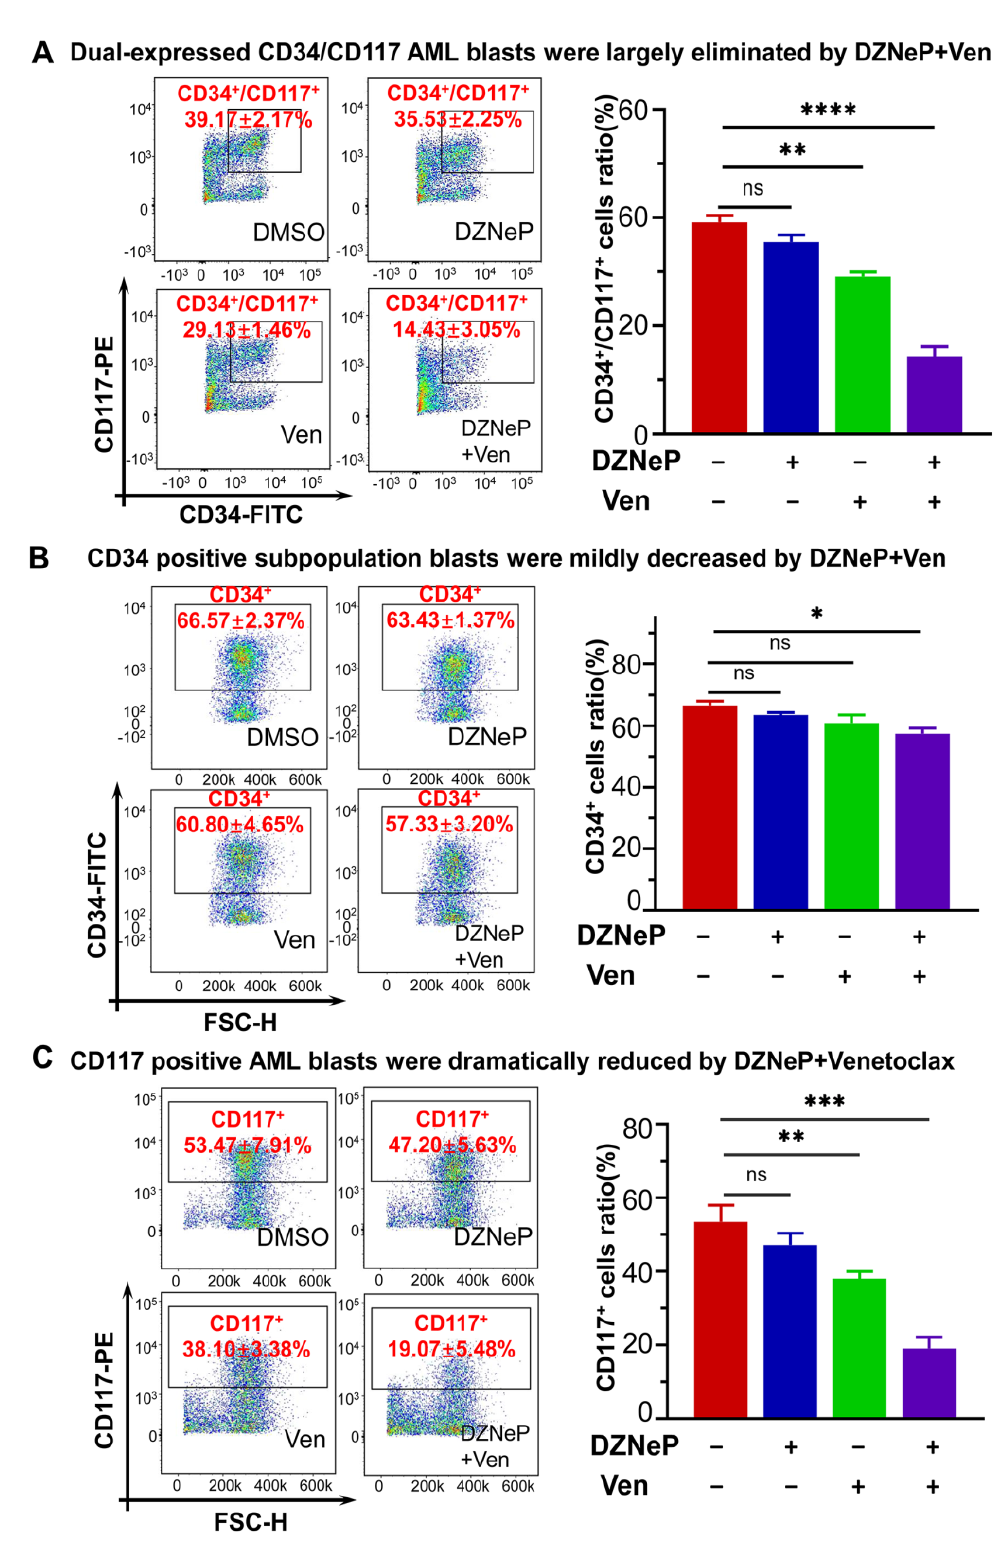
Figure 6. Effect of DZNeP + Ven on the cell growth arrest of c-KIT(CD117)-enriched primary AML blasts. ( A – C ) Effect of DZNeP + Ven on the cell growth arrest in dual CD34+CD17+ ( A ), CD34+ ( B ), and CD117+ ( C ) AML-M5b primary cells. Cells were treated with the indicated drugs for 48 hrs and analyzed by CCK-8 assay. Mean ± SD of triplicates is representative of independent experiments. ns, no significant. * p < 0.05, ** p < 0.01, *** p < 0.001, **** p < 0.0001.